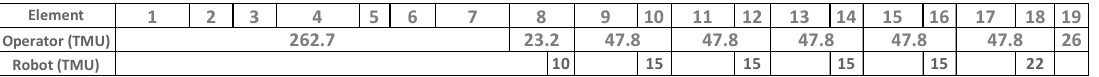
Figure 4. Chronogram of the Rzeppa homokinetic joint assembly.